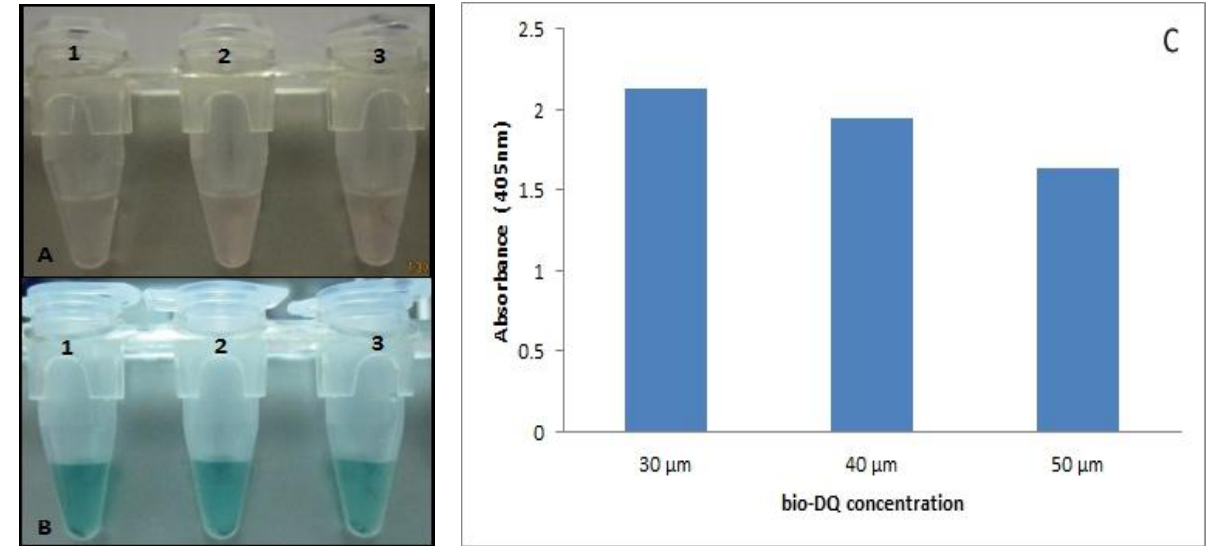
Figure 2. Analysis of antigen-DNAzyme probe based assay. ( A ) pre-ABTS reaction; ( B ) post-ABTS reaction; ( C ) absorbance reading of DNAzyme probes. 200 µg of bio-eGFP was added for each tube with the variations of 30, 40 and 50 µM of bio-DQ added to tubes 1–3, respectively. Two hundred µL ABTS solution added for each reaction and readout was taken at 405 nm. Absorbance readouts were represented in bar chart after 30 min ABTS